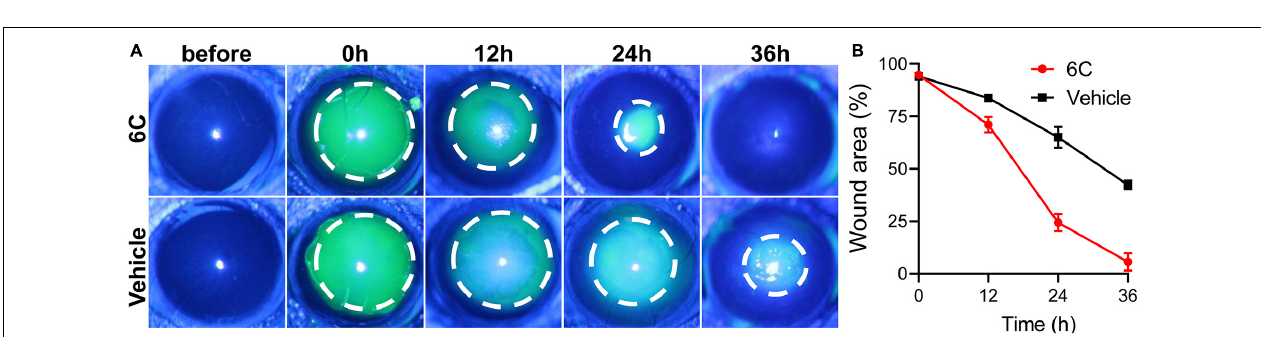
FIGURE 8 | The effect of 6C on wound healing of corneal epithelium in mice. (A) Fluorescein sodium nodded and photographed with a slit lamp. 6C can significantly promote wound healing. (B) Statistical analysis of wound healing.